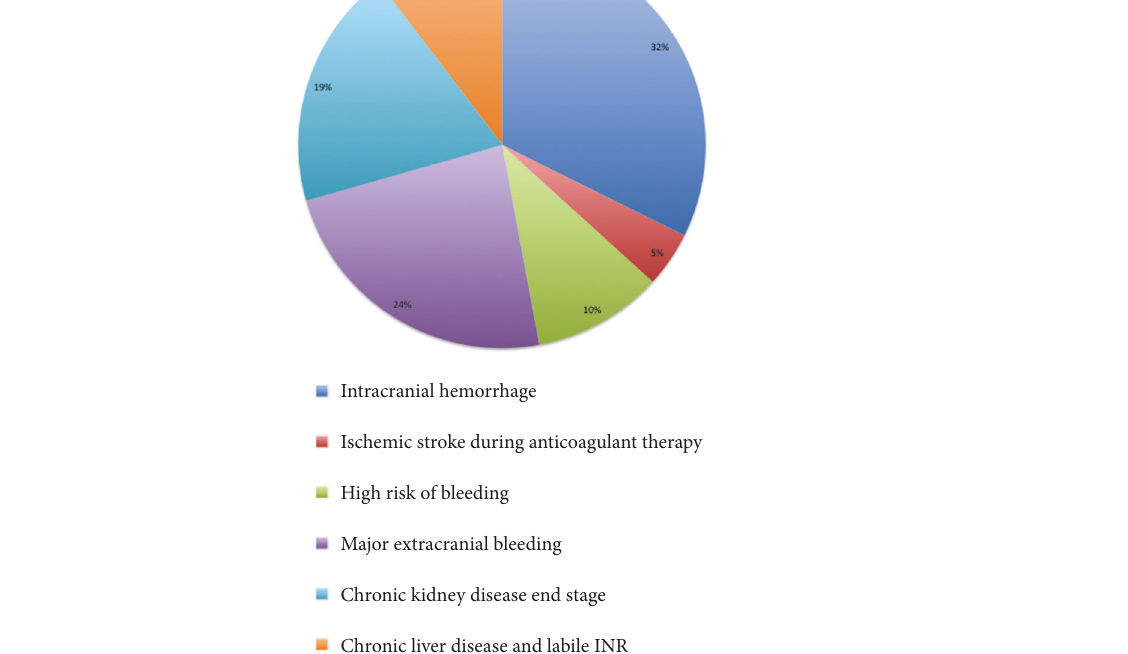
Figure 1: Indication for left atrial appendage closure . Main indications for LAA occlusionwere a history of intracranialhaemorrhage,high risk of bleeding, end-stage chronic kidney disease and chronic liver disease. All the patients had a contraindication to oral anticoagulant therapy.